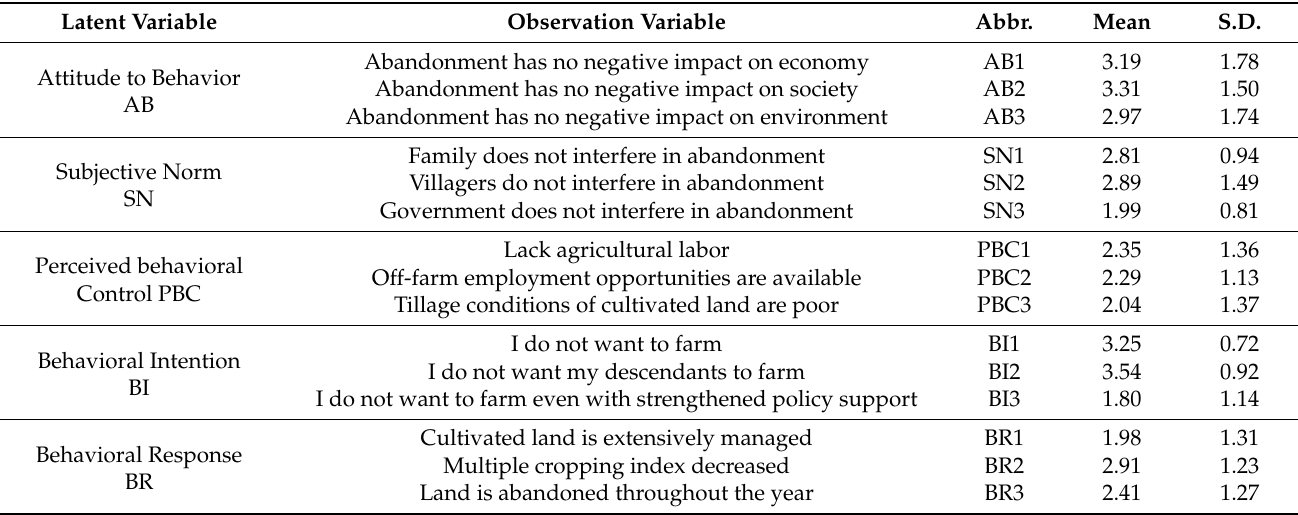
Table 3. Descriptive statistics of